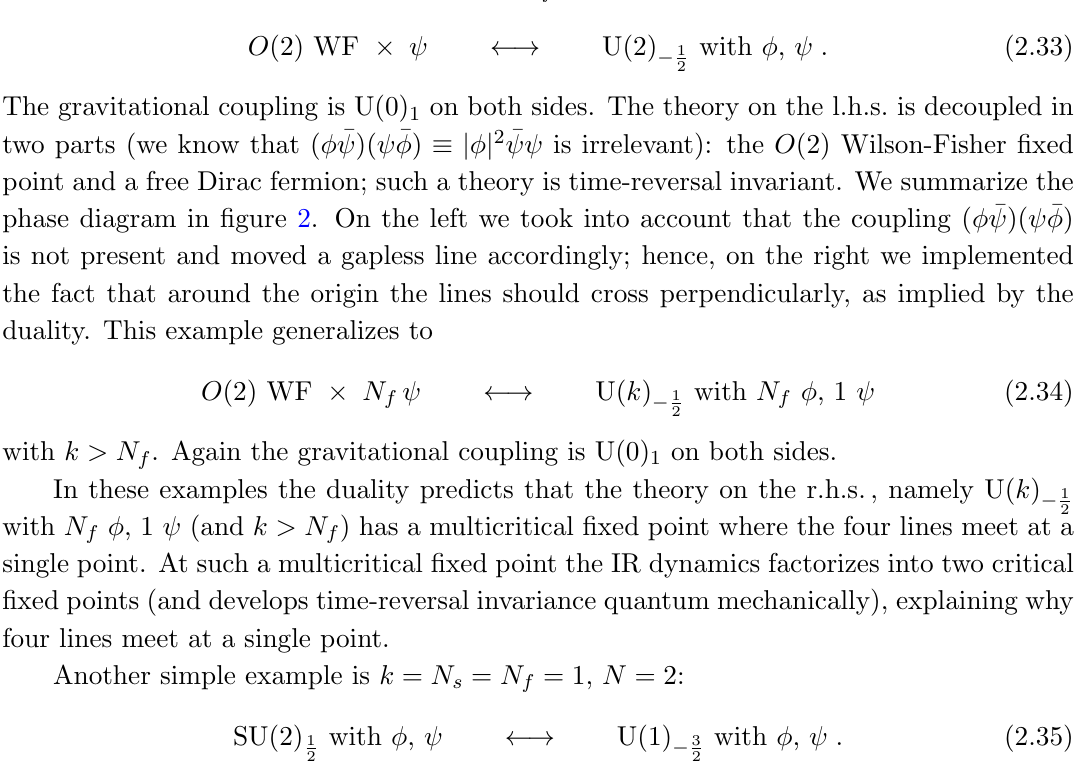
ψ U(2) − 1 with φ, ψ . Phase / 2 × ←→